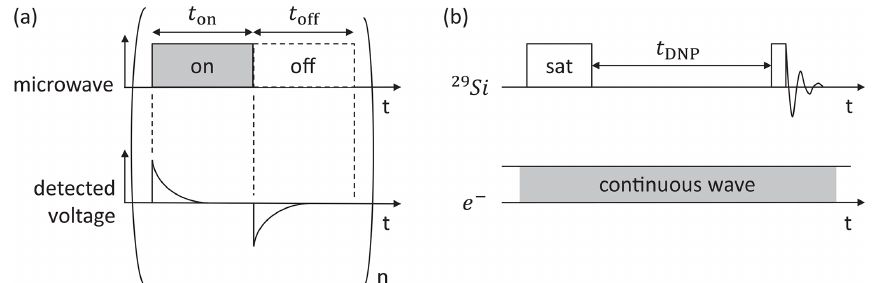
Figure 4. (a) Schematic representation of LOD-EPR experiments. The microwave is modulated on and off n times, while the detected voltage from the LOD coil is averaged for every cycle. (b) Pulse sequence for DNP-enhanced NMR experiments. Both sequences are repeated for different microwave frequencies to obtain the EPR spectrum and the DNP profile respectively.